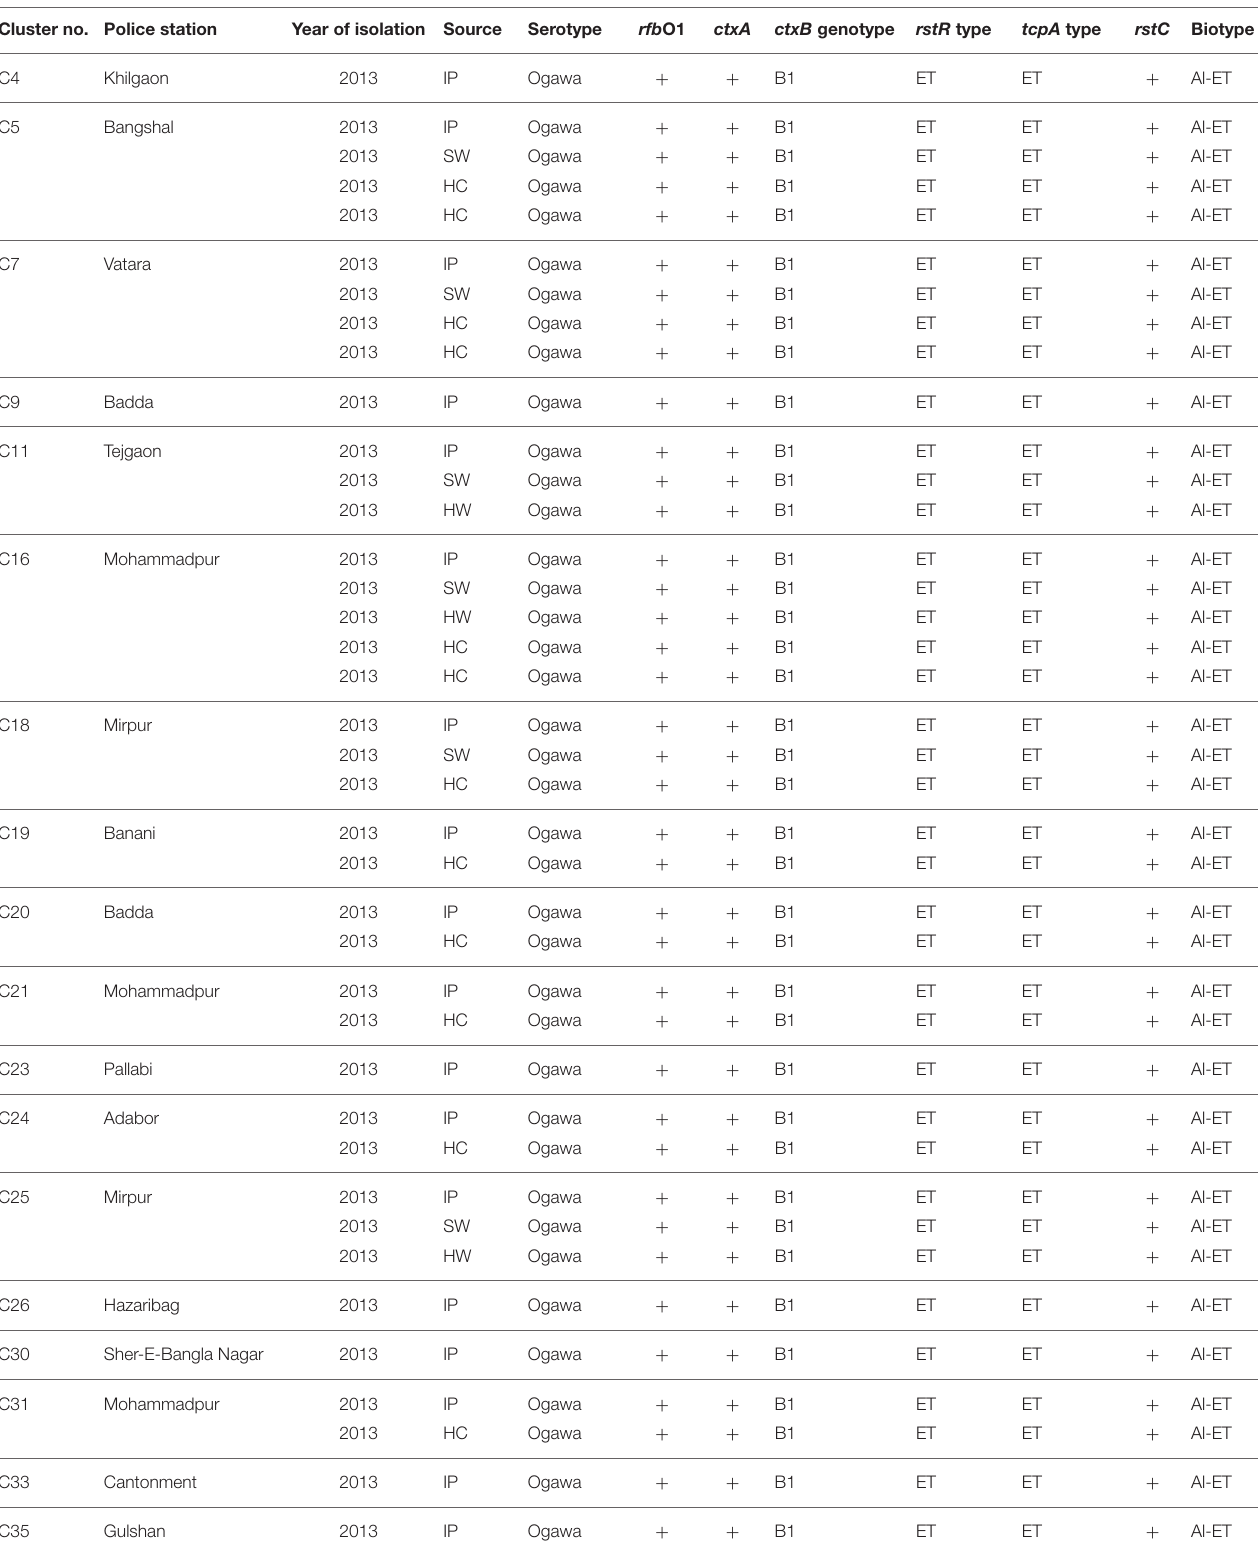
TABLE 1 | Molecular characteristics of Vibrio cholerae O1 isolated from Cholera patients, their family members and drinking water sources. Cluster no. Police